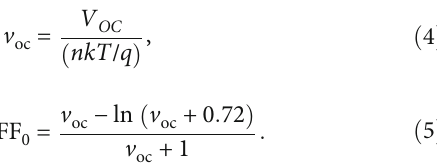
NH PbI Cl x and (b) CH 3 3 3- x